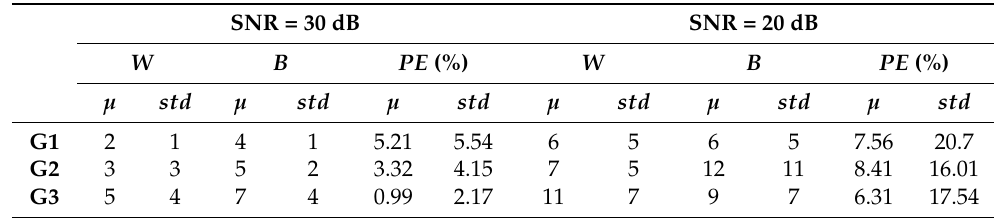
Table 6. Impact of noise on the performance of Method #5.